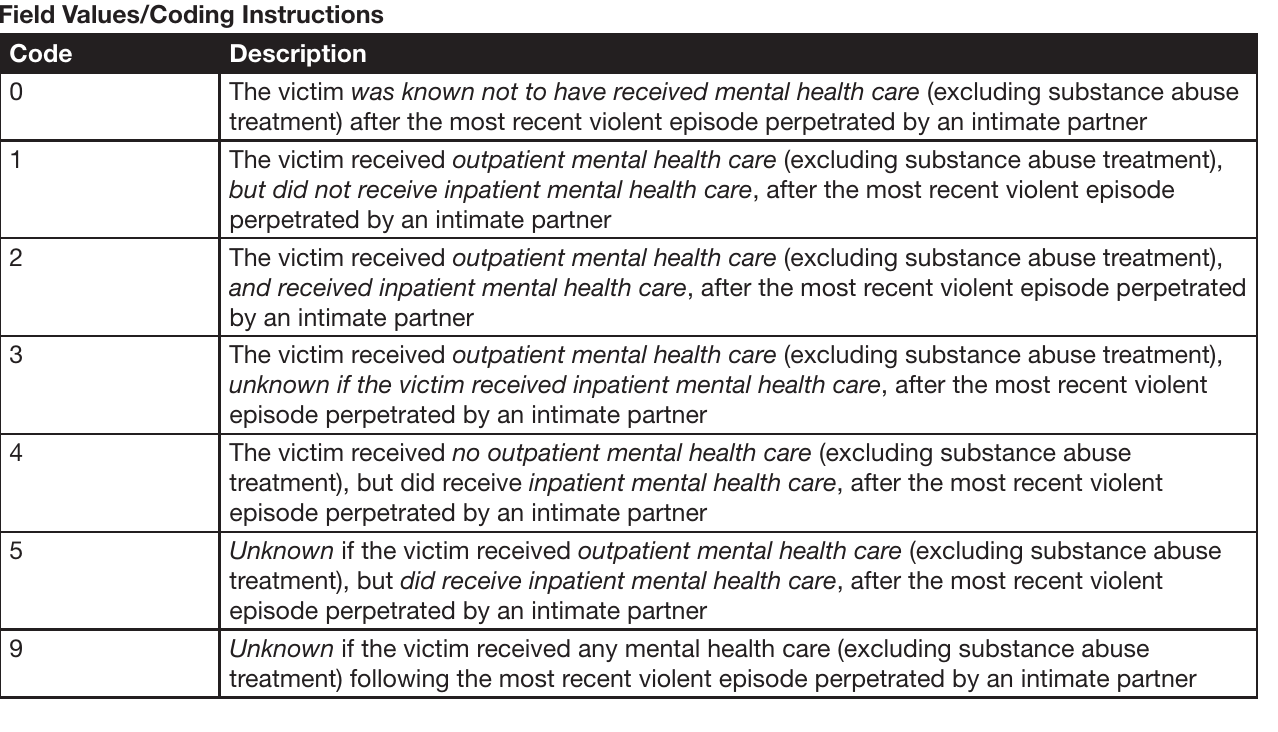
INTIMATE PARTNER VIOLENCE: UNIFORM DEFINITIONS AND RECOMMENDED DATA